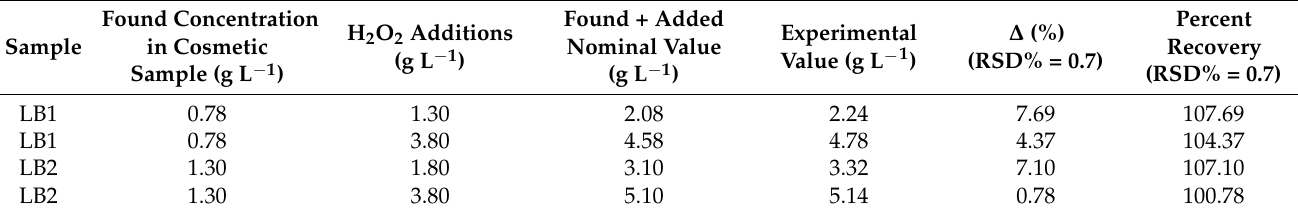
Table 3. Experimental percent recovery for hydrogen peroxide addition in cosmetic samples by Clark-type LDH-catalase enzyme biosensor.